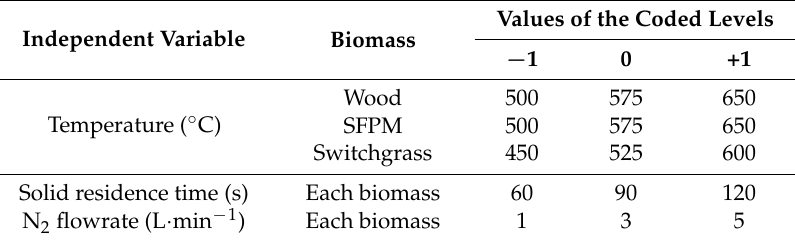
Table 1. Box-Behnken design: list of independent variables and levels. Values of the Coded Levels Independent Variable Biomass − 1 0 +1 Wood Temperature ( ◦ C)